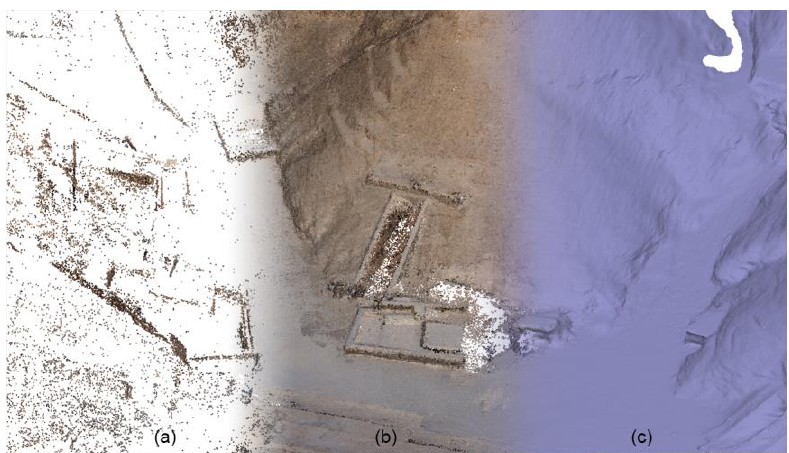
Figure 7. A picture presenting the different 3D photogrammetric products: Sparse point cloud ( a ) dense point cloud ( b ), triangulated mesh ( c ). Table 5. Information concerning the quality of the photogrammetric processing, and the